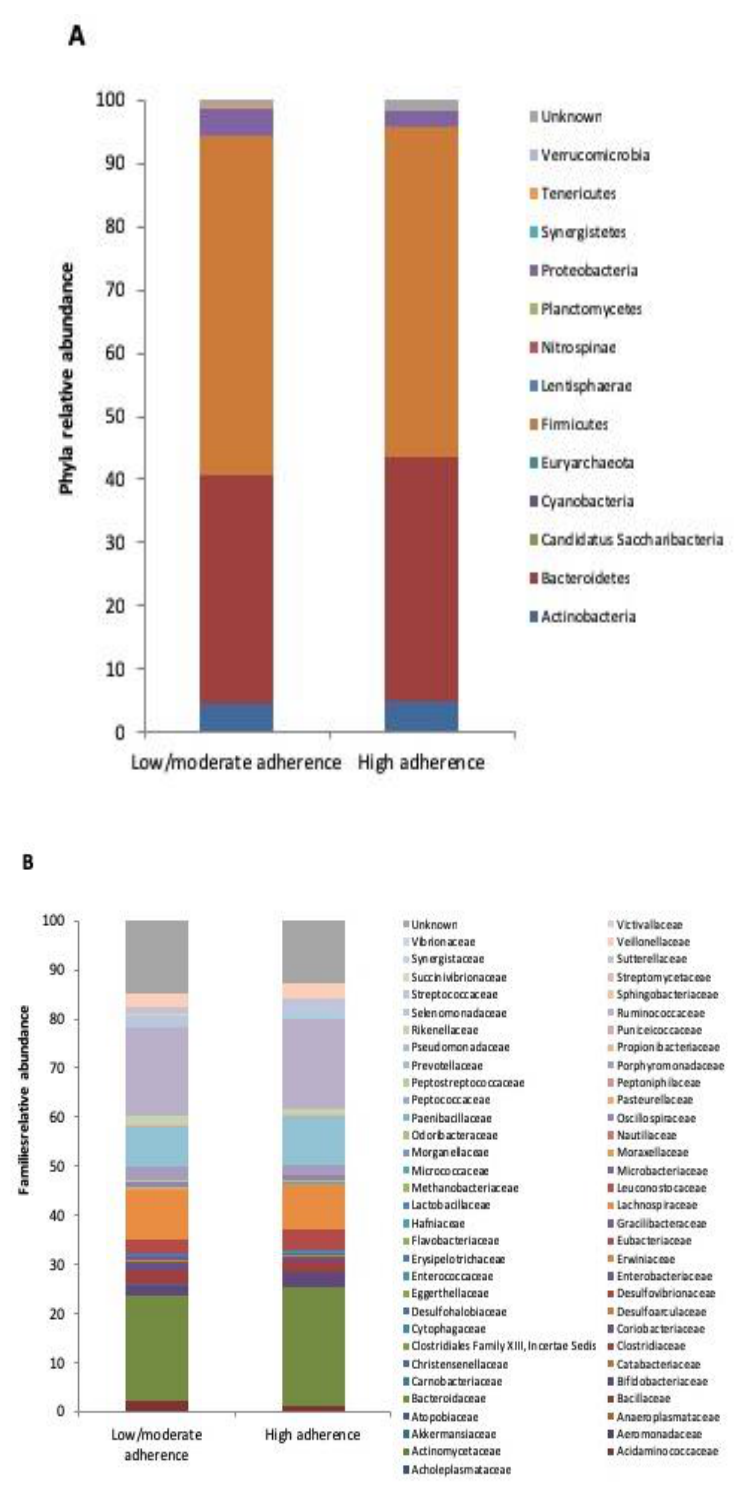
Figure 2. Microbiota composition in low / moderate adherence and high adherence to the Mediterranean diet groups. Mean relative abundance (%) at phyla ( A ) and families ( B ) levels.